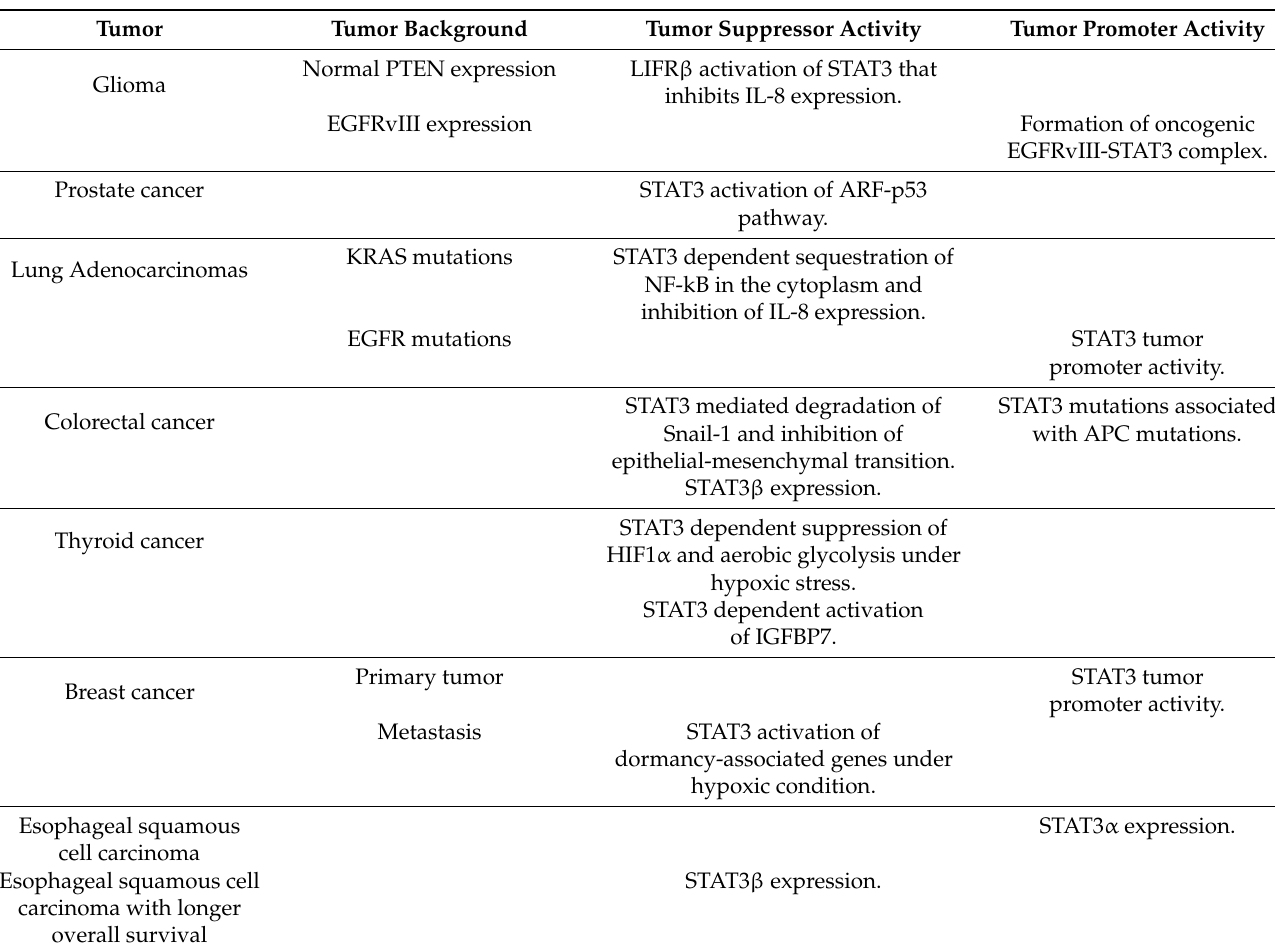
Table 1. Tumor suppressor and tumor promoter mechanisms of Signal transducer and activator of transcription 3 (STAT3) in different